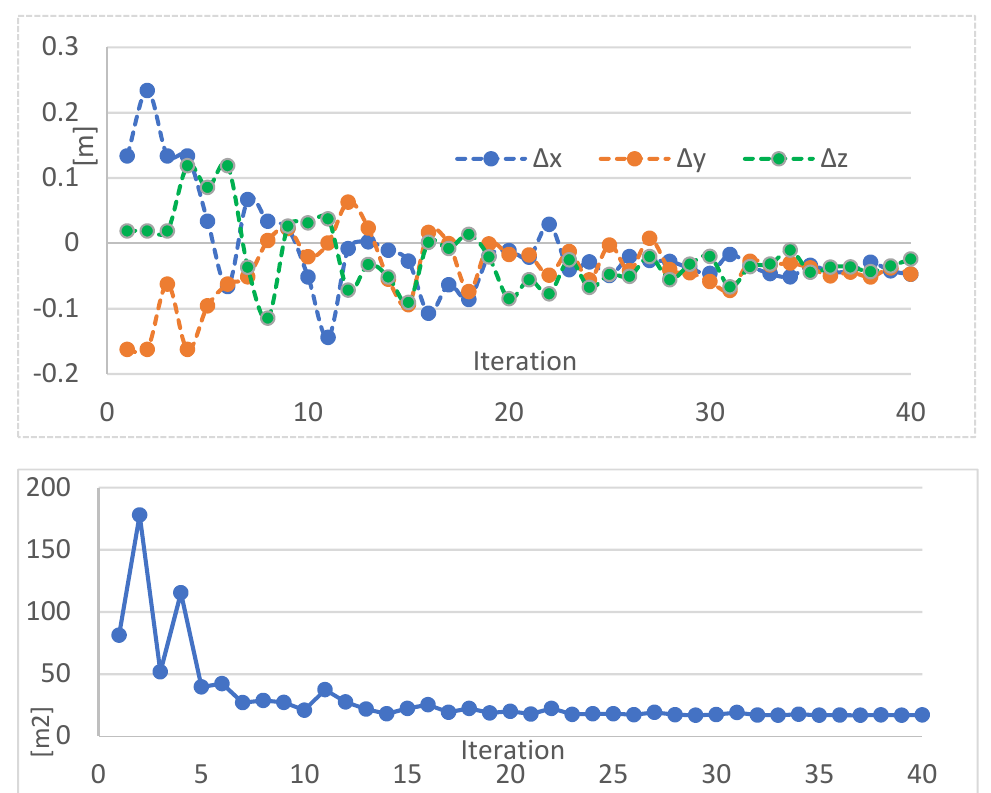
Figure 2. Example results of Nelder-Mead optimization. Convergence of the three parameters ( upper ) and the associated total error as a sum of squared distances ( lower ).